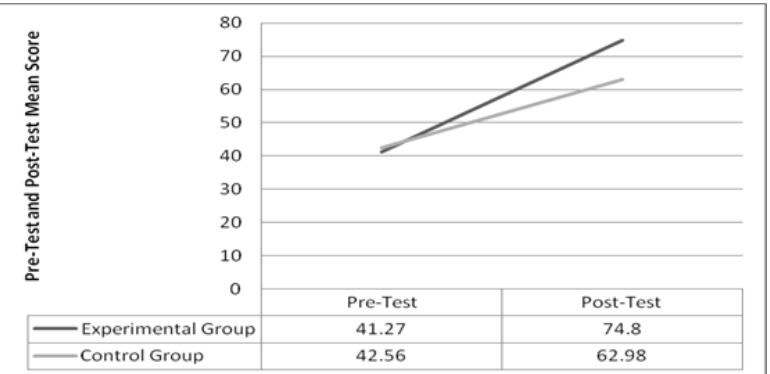
Figure 4 Line graph of pre-test and post-test for the experimental and control